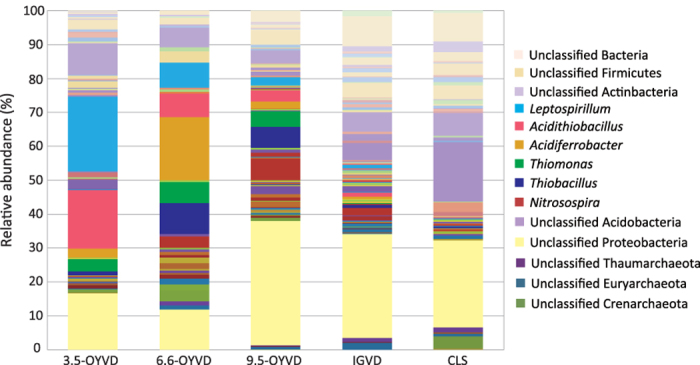
Structure of the prokaryotic microbial community at the genus level.The relative abundance of each genus was calculated as the ratio of individual 16S rRNA gene assigned sequences to the total number of sequences. Colour legends of major genera are shown; those of minor genera are shown as original data in Supplementary Table S4.